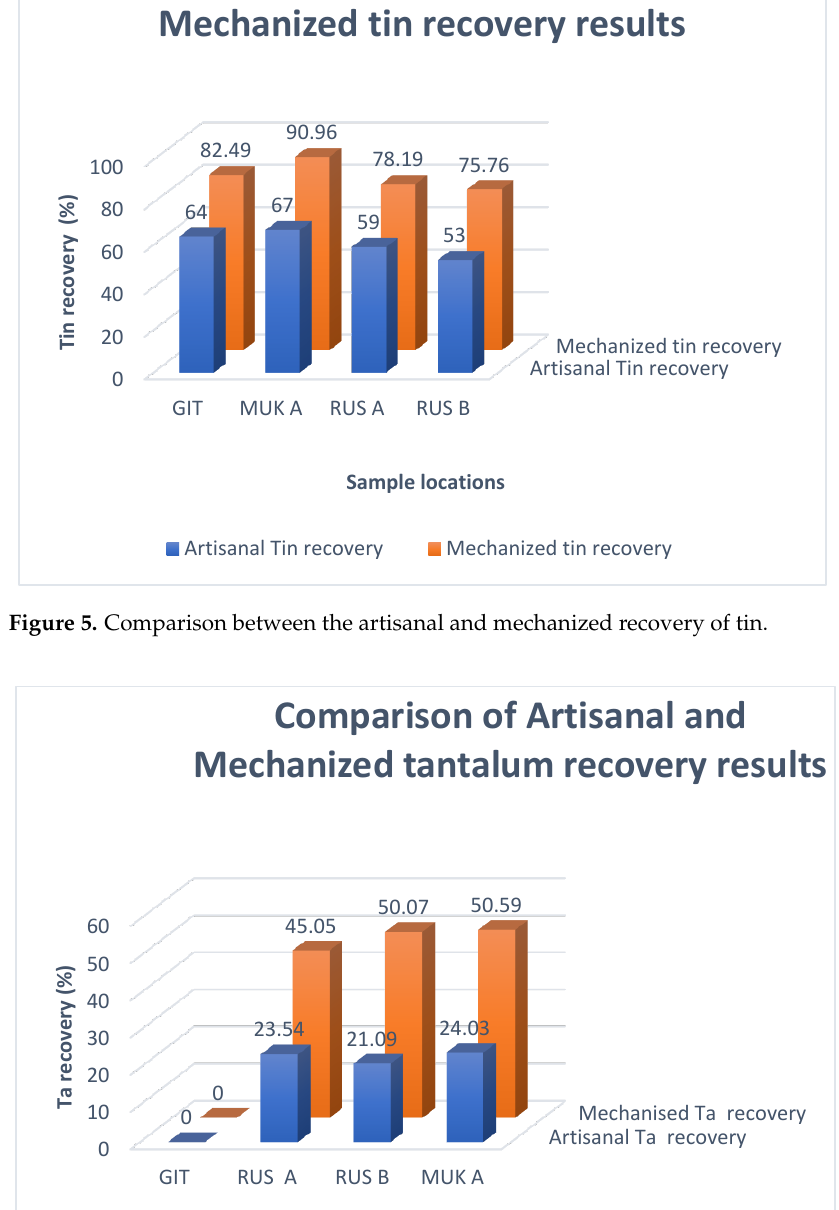
Figure 7. Comparison between tin grades from artisanal and mechanized recovery.